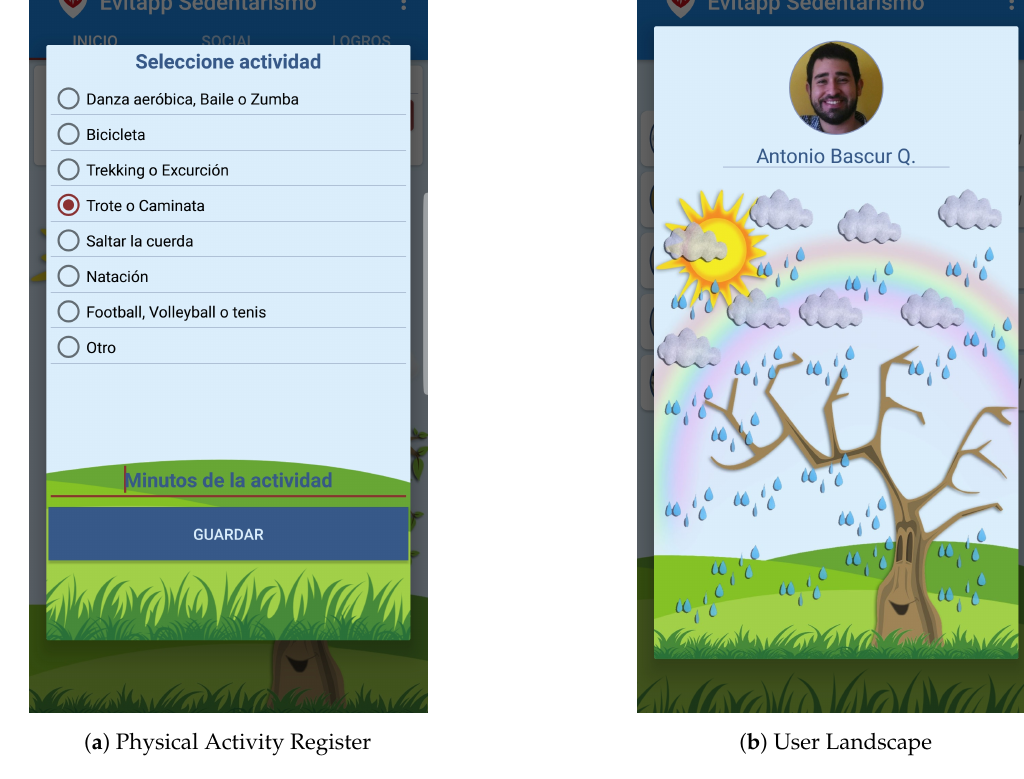
Figure 4. Evitapp Final Version: Physical Activity